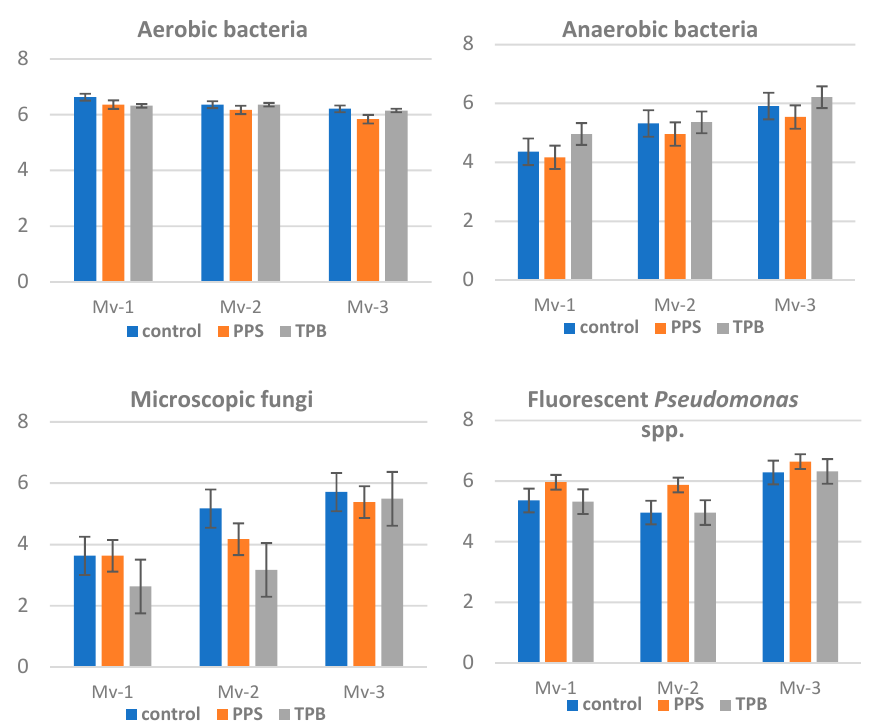
Figure 7. Most probable number (MPN) of certain specific microbial physiological groups, such as aerobic/anaerobic bacteria, microscopic fungi, and fluorescent Pseudomonas sp. count during the vegetation periods, assessed in 2016. Mv-1: sampled after 3 weeks of inoculation, Mv-2 at the 60% of flowering stage, Mv-3 at the harvest in August. Treatments: PPS contains Pseudomonas protegens , Pseudomonas jessenii , and Stenotrophomonas maltophilia ; TPB contains Trichoderma atroviride , Pseudomonas putida , and Bacillus subtilis. ( n = 3).